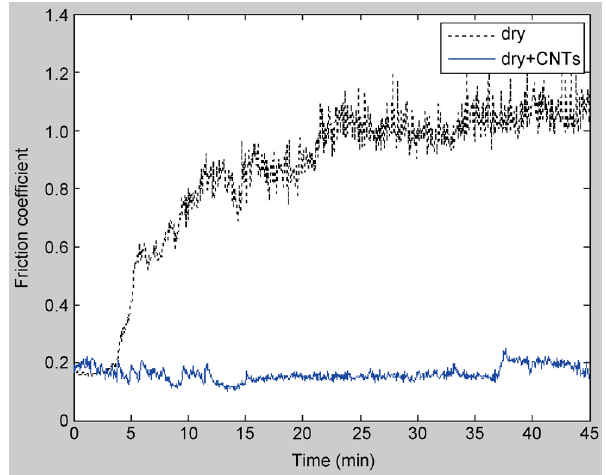
Fig. 3 Friction coefficients with or without CNTs under dry sliding